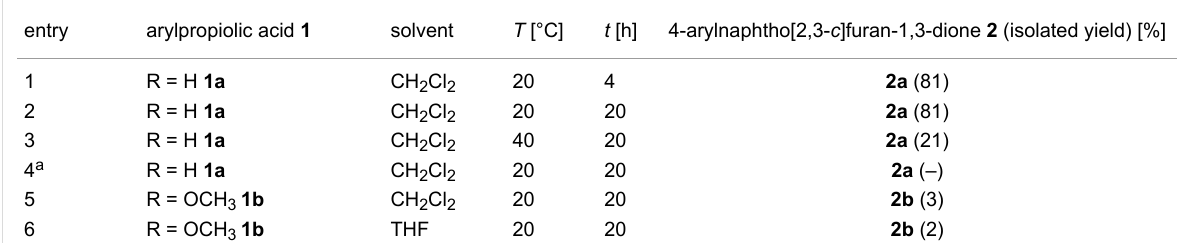
Table 1: Optimization of the reaction conditions for the synthesis of 4-arylnaphtho[2,3- c ]furan-1,3-diones 2 .